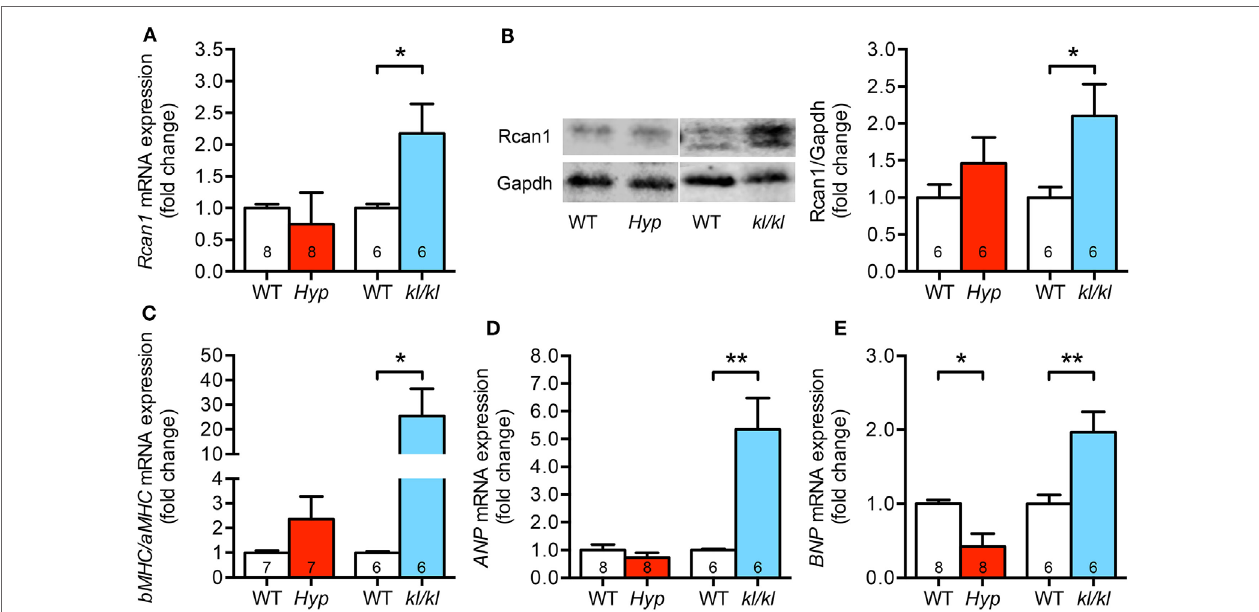
FigUre 4 | Kl/kl mice show an upregulation of cardiac pro-hypertrophic nuclear factor of activated T cell target genes. (a,b) Rcan1 expression is increased only in cardiac tissue from kl/kl mice demonstrated by quantification of mRNA levels by real-time PCR and protein levels by western blotting. (c) Quantification of bMHC and aMHC mRNA expression shows the induction of fetal gene program in heart tissue from kl/kl mice but not from Hyp mice. (D) ANP mRNA expression is induced in the myocardium of kl/kl mice in relation to respective wild-type animals. (e) Cardiac BNP mRNA expression is reduced in Hyp mice, but upregulated in kl/kl mice. Values are presented as mean ± SEM; numbers in each bar graph represent the n -values used for the respective measurement; * P < 0.05, ** P <